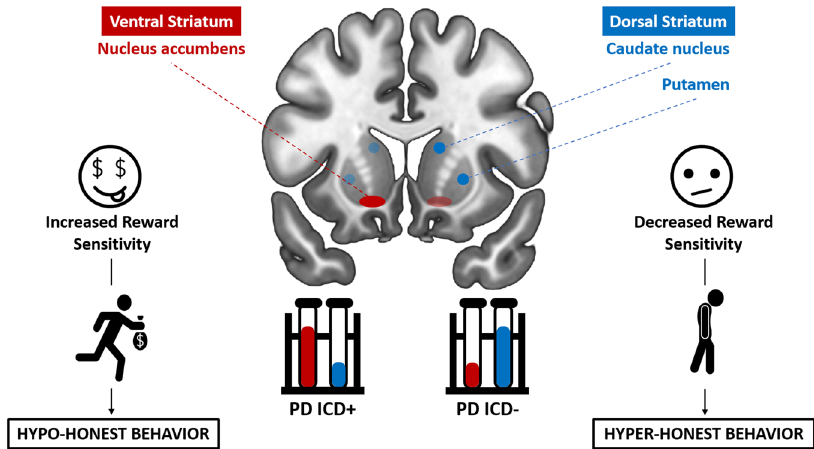
Fig. 1 Alterations of dopaminergic striatal levels may lead to hypo- or hyper-honesty in PD. Schematic overview of the role of dopaminergic striatal levels in explaining the behavioral transition from the purported dynamic balance of health condition to the unbalance that leads to hypo- or hyper-honesty in PD. The dopaminergic imbalance between the ventral and dorsal striatum may alter the brain motivation system and thus enhance/decrease the salience of reward-related stimuli. Altered incentive salience (i.e., “ wanting ” ) may in turn explain the hypo- and hyper-honest behavioral tendencies expressed by PD patients during deceptive decision-making. This model is inspired by a recent meta-analysis 90 . The hypo- and hyper-honest behavioral tendencies have been displayed respectively on the left and right side of the fi gure only for representational purposes. No hypothesis on brain lateralization has been